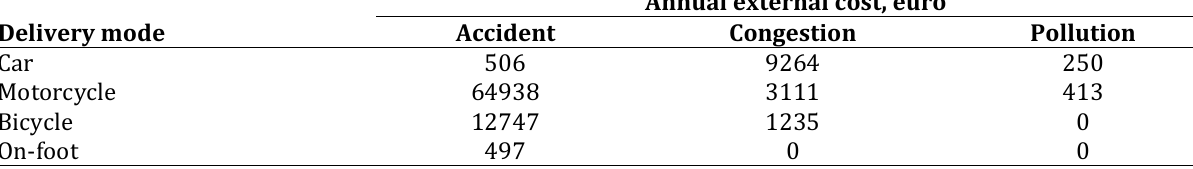
Table 3: Annual external cost for various types of urban delivery modes